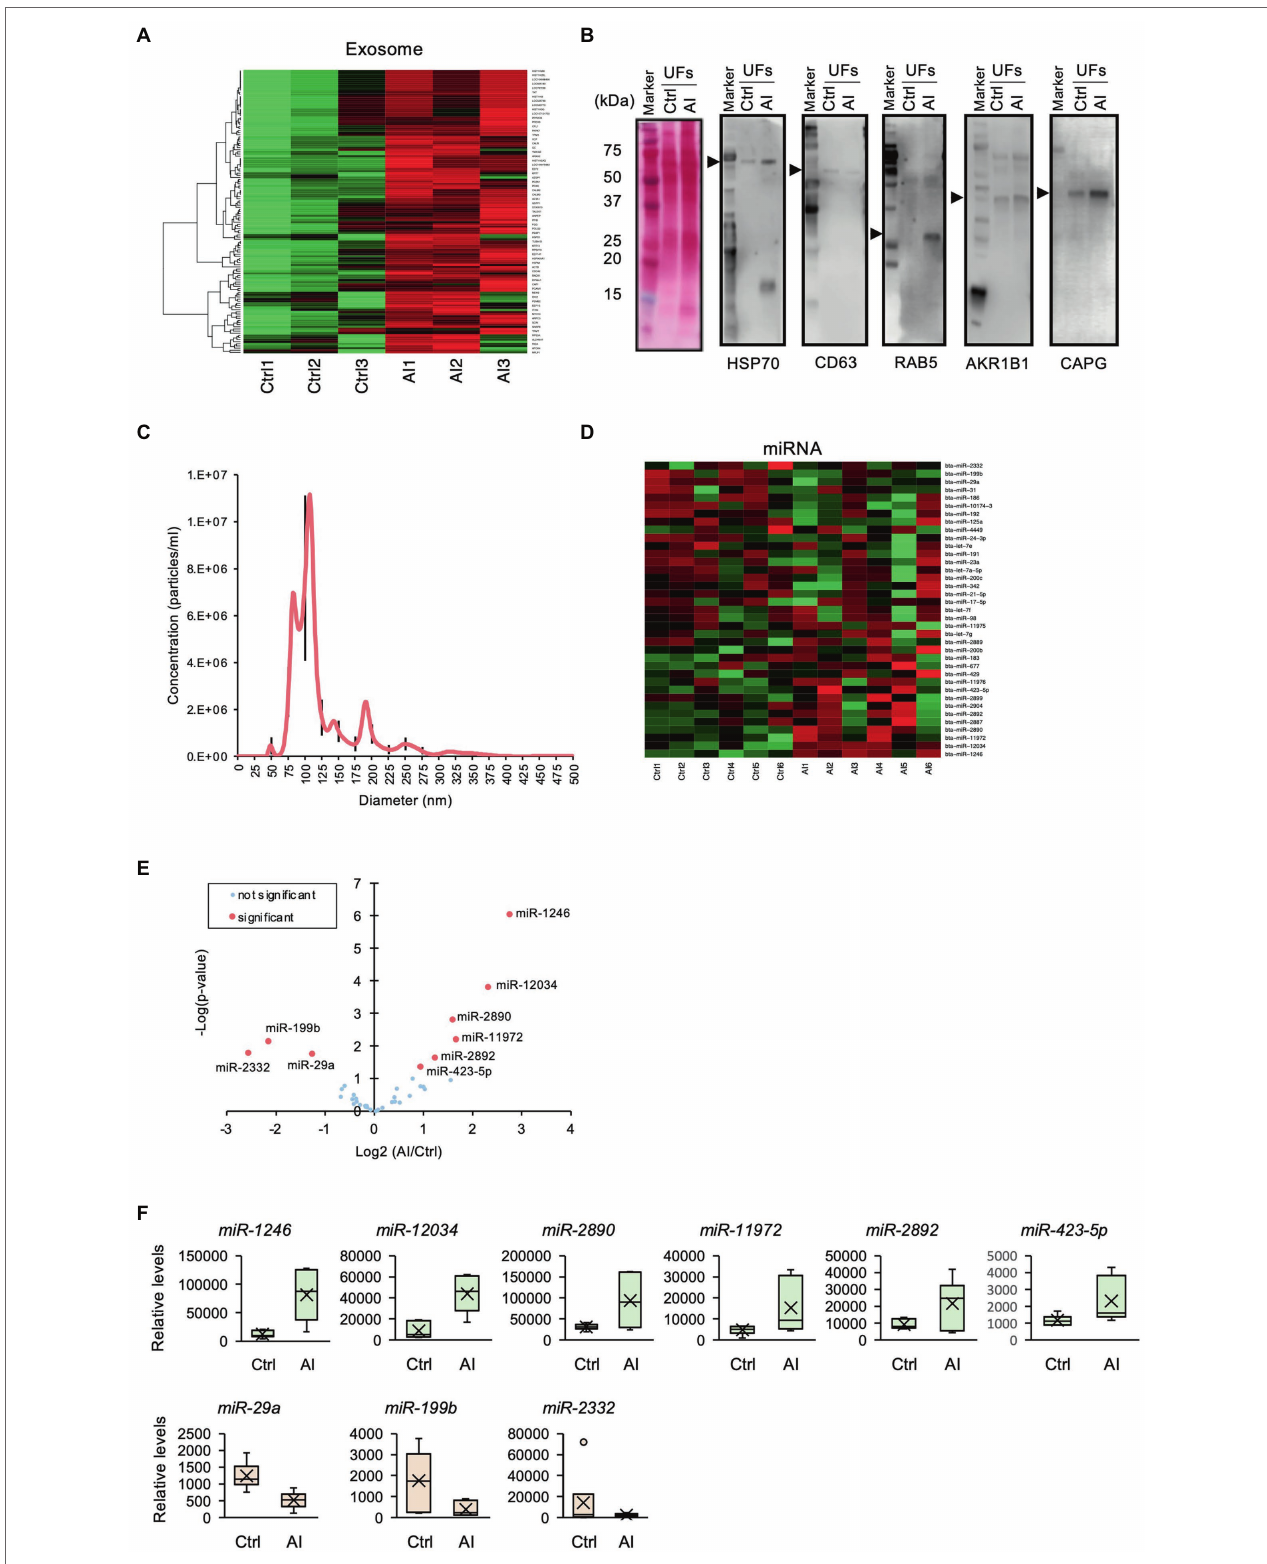
FIGURE 4 | Profile of exosomal miRNAs in uterine flush (UF) collected on D7 after the estrus. (A) Heat-map analysis of exosome-related genes found in the UF